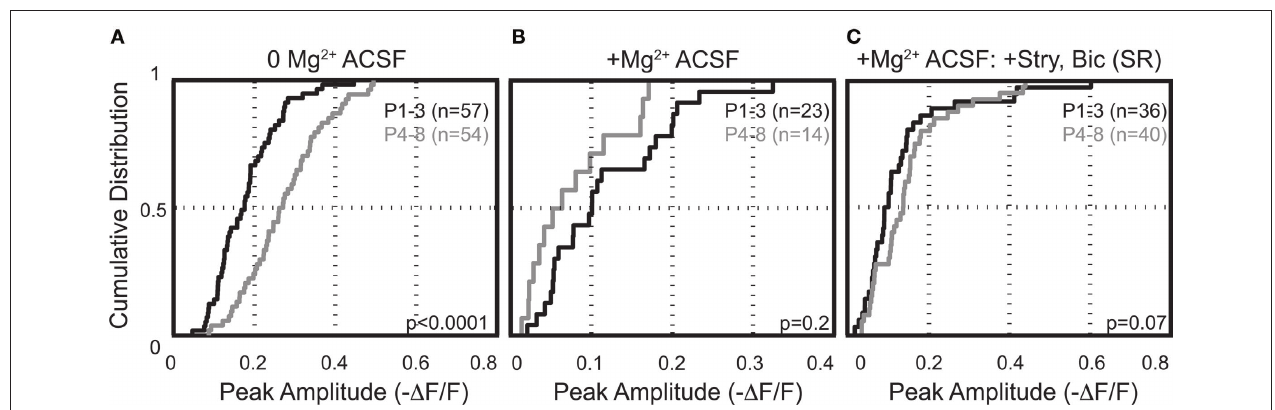
FiGUre 8 | MNTB-elicited somatic Ca 2 + responses recorded in 0 Mg 2 + (A) increased during the first postnatal week. Responses recorded in physiological Mg 2 + with (B) or without (C) glycine/GABAergic conductances are not different developmentally, which suggests a developmental increase in the number of NMDAR- only synapses.